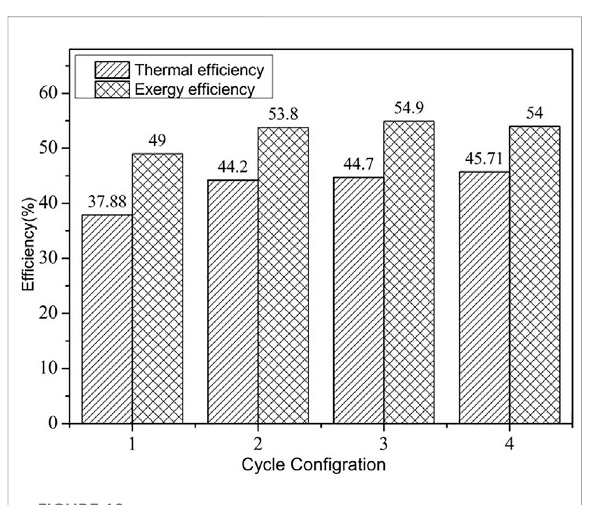
FIGURE 10 Comparison of the thermal ef fi ciency and exergy ef fi ciency of different cycle con fi